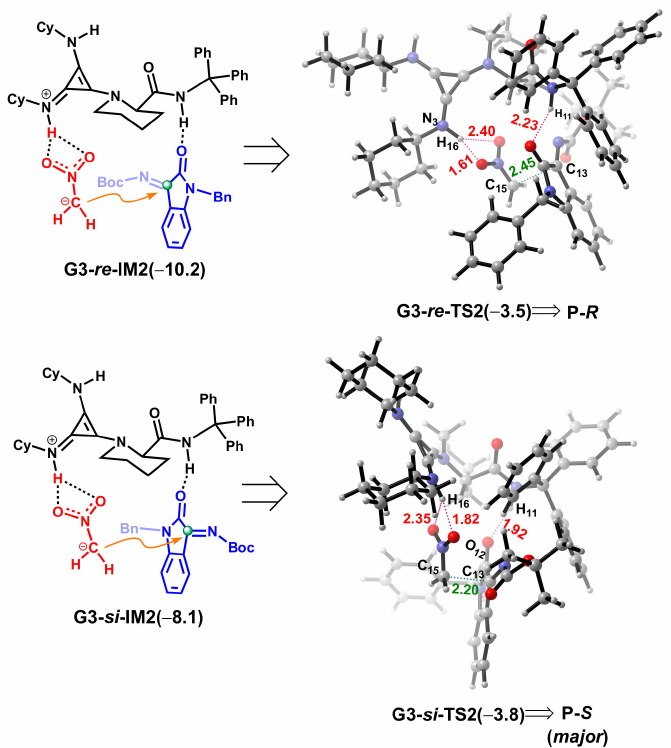
Figure 10. Optimized structures and the relative Gibbs free energies (in kcal · mol − 1 ) of two competing transition states (G3- re -TS2 and G3- si -TS2) in the C–C bonding formation step of the aza-Henry reaction catalyzed by G3. The distances are in